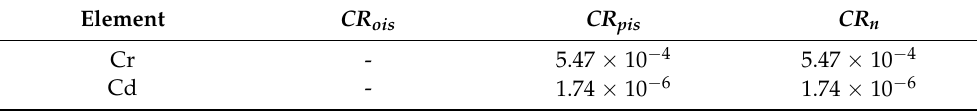
Table 7. CR results for each exposure pathway of Cr and